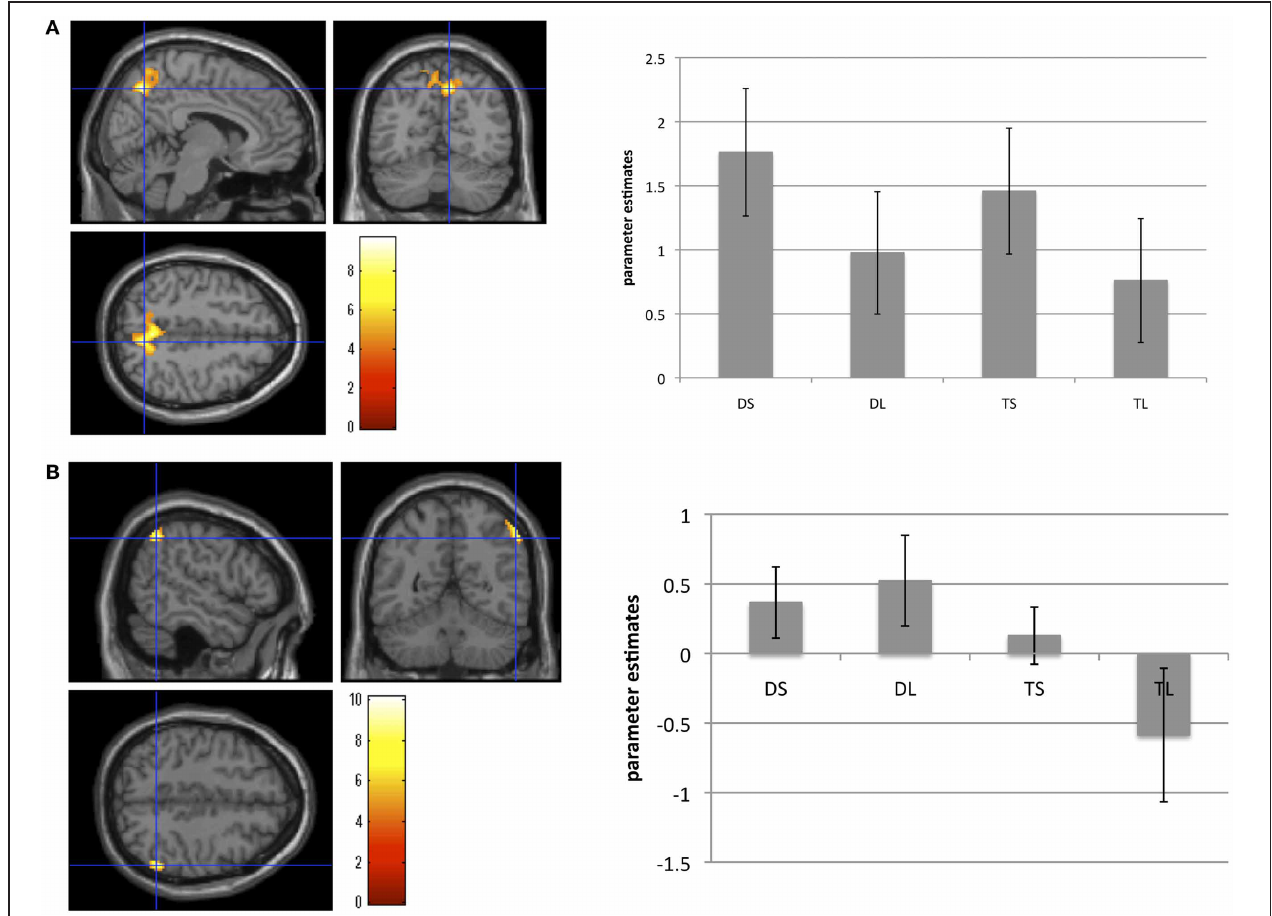
FIGURE 2 | Brain areas showingbrain activation during(A) the social conditionscompared withthe less-social conditions,and (B) the deceptionconditionscomparedwiththetruthconditions. Activation inthe right precuneus areas was significantly greater under the social than under the